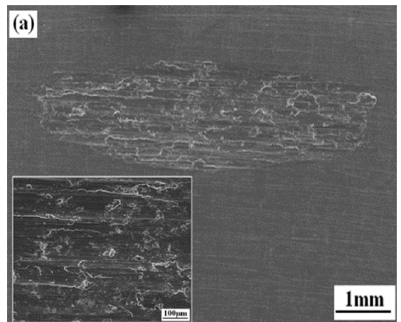
Figure 13. Friction coefficient of the substrate and the coatings with different concentrations of graphene.